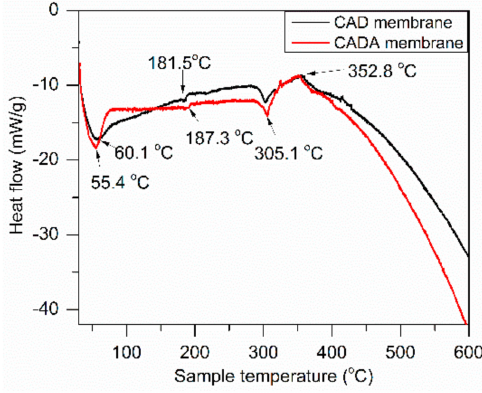
Figure 7. DSC curves of CAD and CADA membranes.